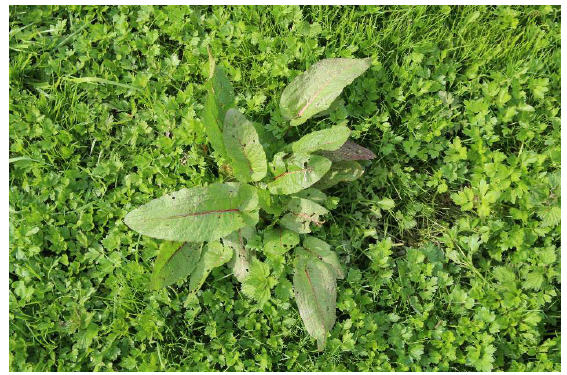
Figure 1. Rumex ( Rumex obtusifolius) with an approximated area of 200 cm 2